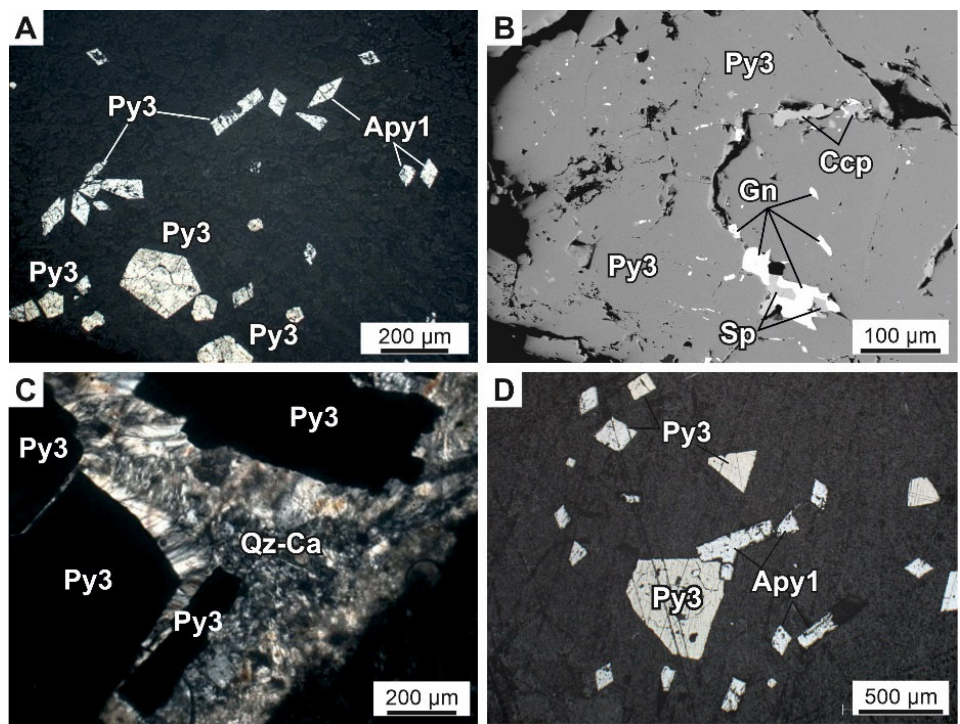
Figure 10. Microtextures of alteration pyrite3 and arsenopyrite1 from proximal alteration rock sediment-hosted OGDs ( A – C ) and from proximal alteration rock intrusion-hosted OGDs ( D ) (( A , C , D ) reflected light and ( B ) backscattered electron images), central YKMB. ( A ) Dissemination of Py3 and Apy1: pentagondodecahedral shape and zoning are characteristic of individual large pyrite crystals; ( B ) microinclusions of galena (gn), chalcopyrite (Ccp), and sphalerite (Sp) in pores, voids, and microcracks of pyrite crystals; ( C ) rod-like rims of quartz–carbonate composition; ( D ) dissemination of the alteration Py3 and Apy1 in a